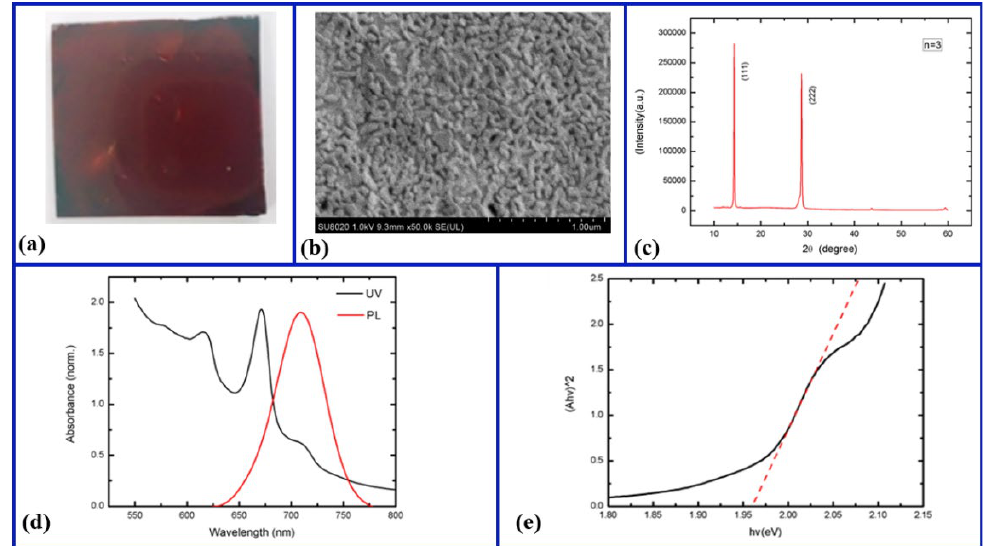
Figure 3. Structural morphologies and optical properties of (PEA) 2 (MA) 2 Pb 3 I 10 perovskite: ( a ) optical microscope image, ( b ) SEM image, ( c ) XRD patterm, ( d ) absorption profile and PL spectrum, and ( e ) bandgap extraction.